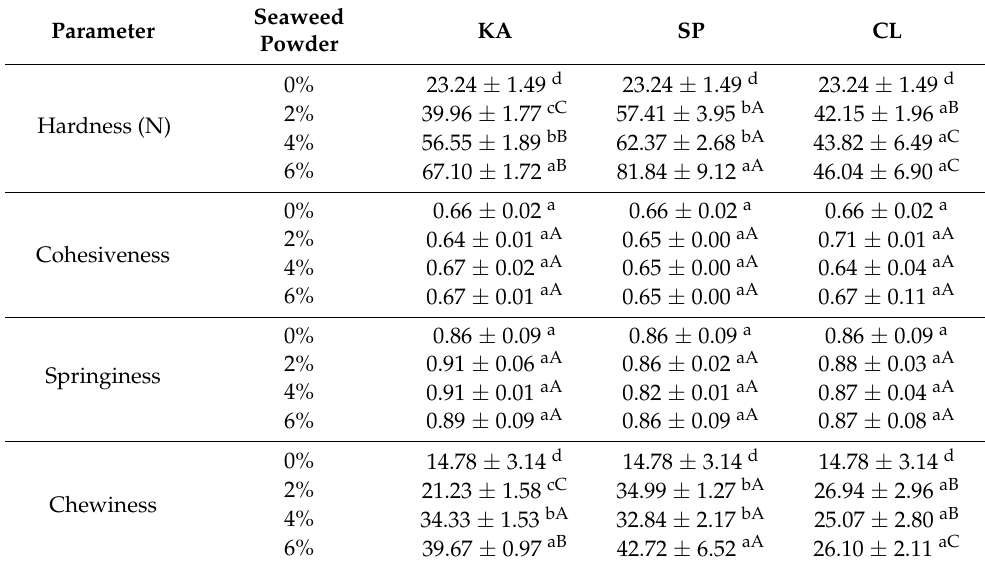
Table 5. Texture profile analysis of all sausage formulations.